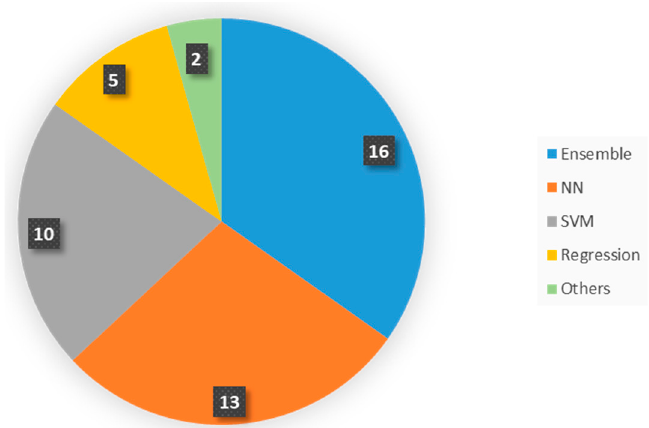
Figure 4. Proportion of machine learning algorithms used. ‘Ensemble’ stands for Ensemble Learning (mainly Random Forest). ‘NN’ stands for any algorithm based on an Artificial Neural Networks approach. ‘SVM’ stands for Support Vector Machine (it also includes Support Vector Regression). ‘Regression’ stands for Multiple Linear Regression. ‘Others’ includes Decision Rules and Lazy methods.